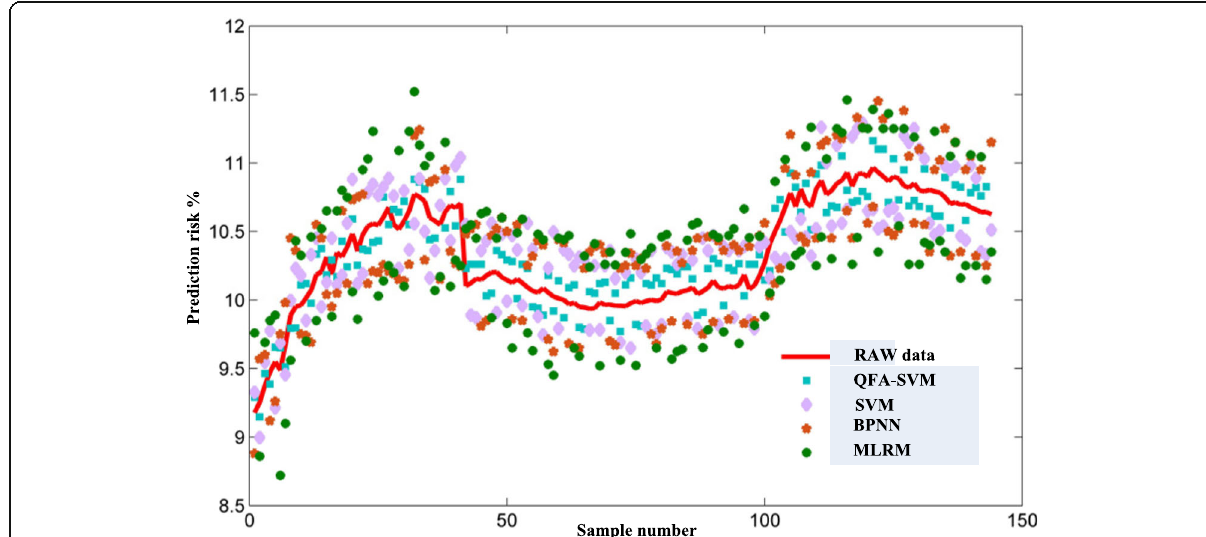
Fig. 5 The prediction risk of the